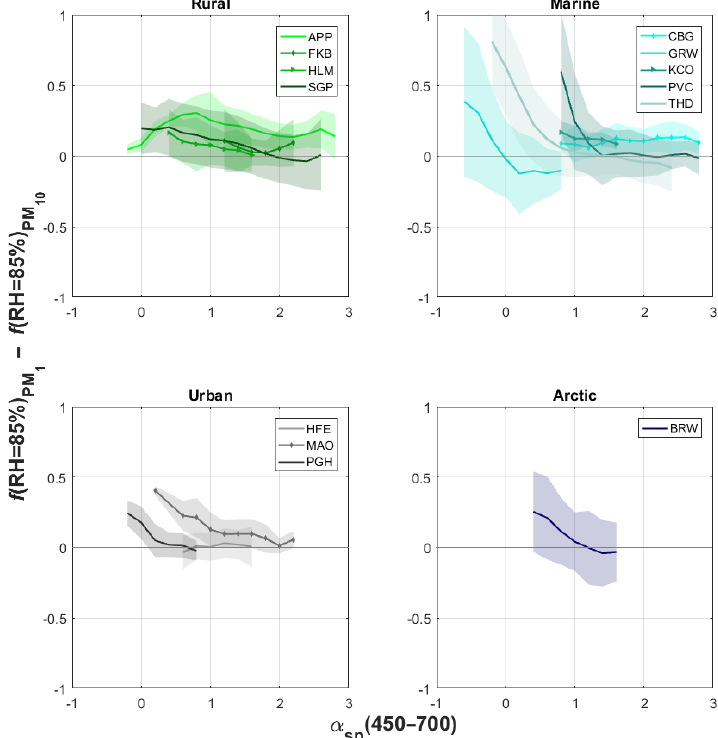
Figure 3. Difference in the f (RH = 85%) in PM 1 and PM 10 size fractions at 550nm as a function of the dry scattering Ångström exponent, α sp , calculated between 700 and 450nm. The solid line represents the mean value, and the shaded region represents ± 1 standard deviation. The points are binned in increments of 0.2 α sp . Only bins with standard error below 0.03 are